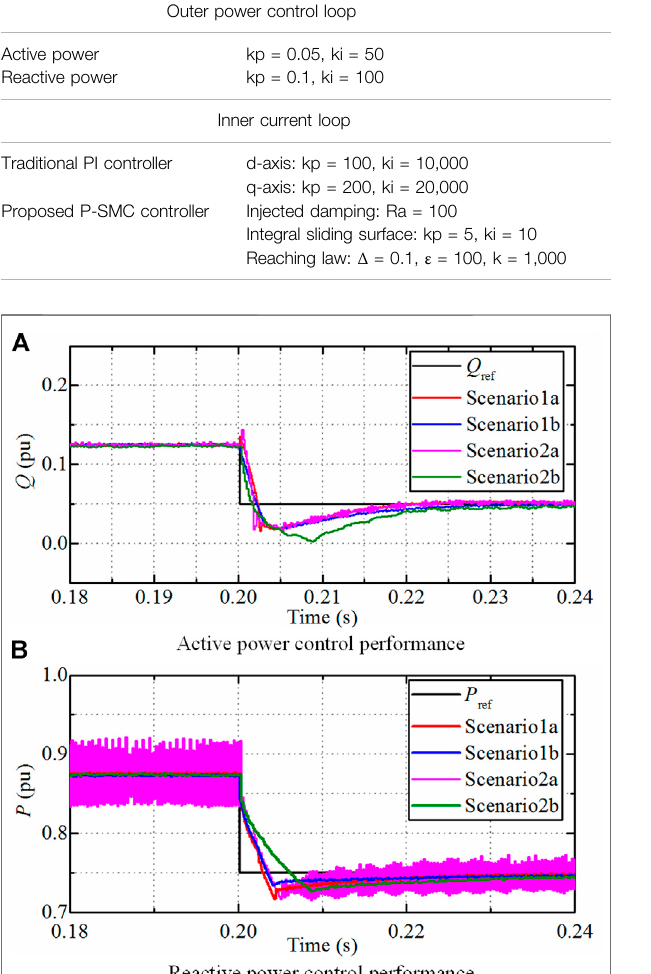
FIGURE 9 | Treatment strategy performance under unbalanced grid voltage.